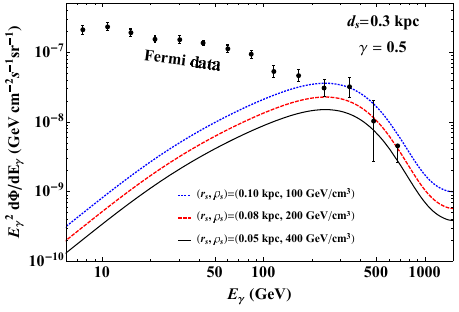
Figure 10 . Fermi IGRB data [61] and gamma rays from DM for di(cid:11)erent subhalo pro(cid:12)les. Here V 1 is electrophilic and V 2 is L (cid:22) (cid:0) L (cid:28) gauged. Here d s = 0 : 3 kpc and b SH = 0 (cid:14) . The DM annihilation cross sections are h (cid:27)v i 1 = 2 : 33 (cid:2) 10 (cid:0) 26 cm 3 /s and h (cid:27)v i 2 = 1 : 06 (cid:2) 10 (cid:0) 24 cm 3 /s, for the case where r s = 0 : 05 kpc and (cid:26) s = 400 GeV/cm 3 . The DM annihilation cross sections are h (cid:27)v i 1 = 2 : 26 (cid:2) 10 (cid:0) 26 cm 3 /s and h (cid:27)v i 2 = 1 : 05 (cid:2) 10 (cid:0) 24 cm 3 /s, for the case where r s = 0 : 08 kpc, (cid:26) s = 200 GeV/cm 3 . For the case where r s = 0 : 1 kpc, (cid:26) s = 100 GeV/cm 3 , the DM annihilation cross sections are listed in table